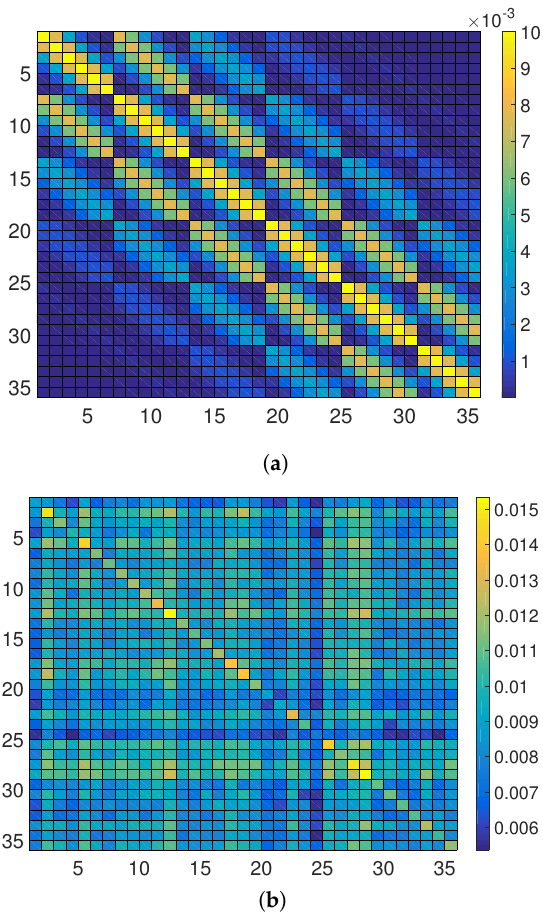
Figure 9. ( a ) Spatial covariance matrix generated by the squared exponential function ( σ 2 s = 0.01, θ = 2); ( b ) Randomly generated spatial covariance matrix.